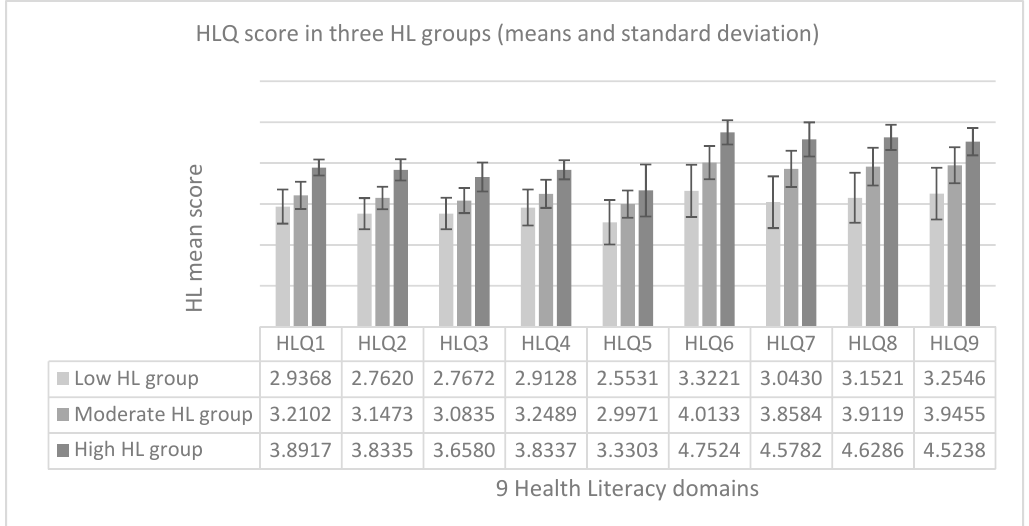
Figure 1. Health Literacy Questionnaire (HLQ) mean scores of 9 domains in three health literacy (HL) groups.